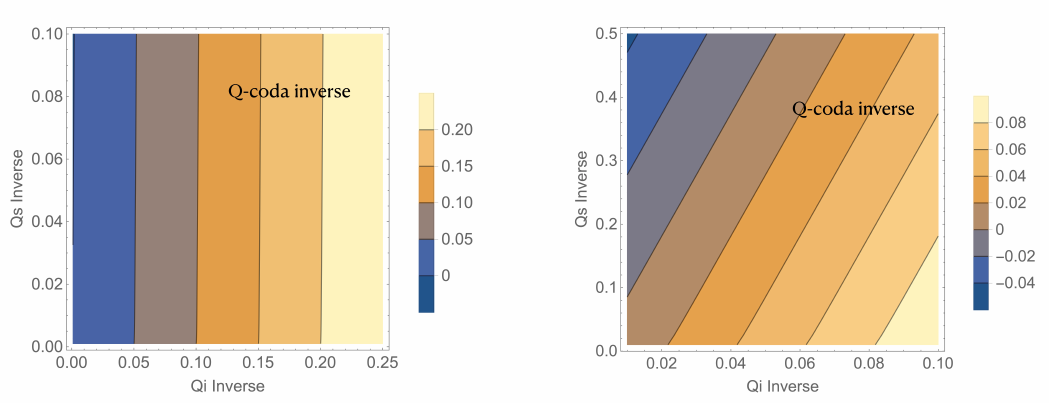
Figure 7. Contours of Q − 1 c as a function of Q − 1 and Q − 1 s calculated fitting ETM with SSM in the time i interval between origin time and 30s lapse. ( Left ) Q − 1 c does not depend on Q − 1 s for media with low Q − 1 s . ( Right ) in the case of high heterogeneity ( Q − 1 s > 0.1 ) the trade off